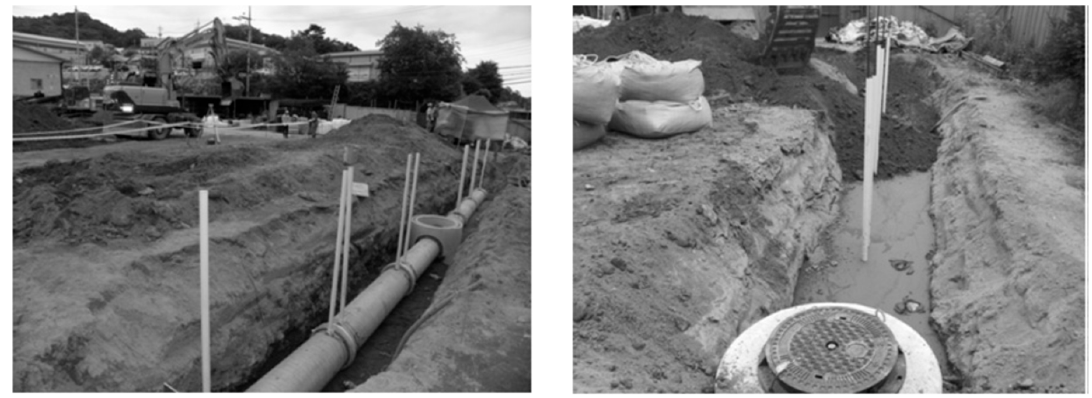
Figure 2. Backfilling of buried pipes using controlled low-strength material (CLSM) [6].